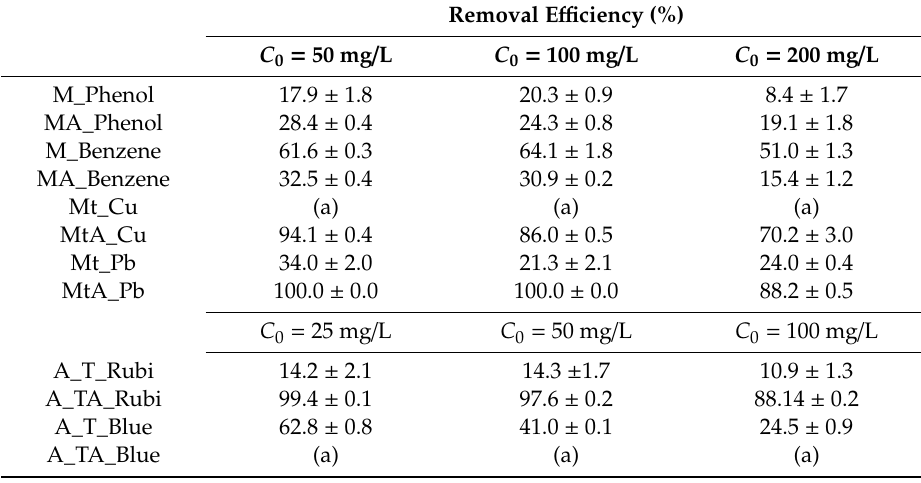
Table 5. Removal adsorption e ffi ciencies of the materials for di ff erent pollutants against initial concentrations, C 0 , used in the equilibrium